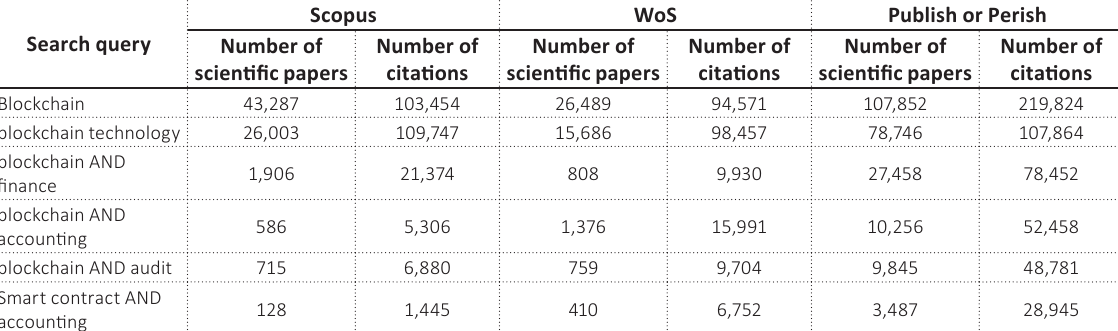
Table 1. Statistical analysis of search queries on the topic of blockchain technology in the scientific literature